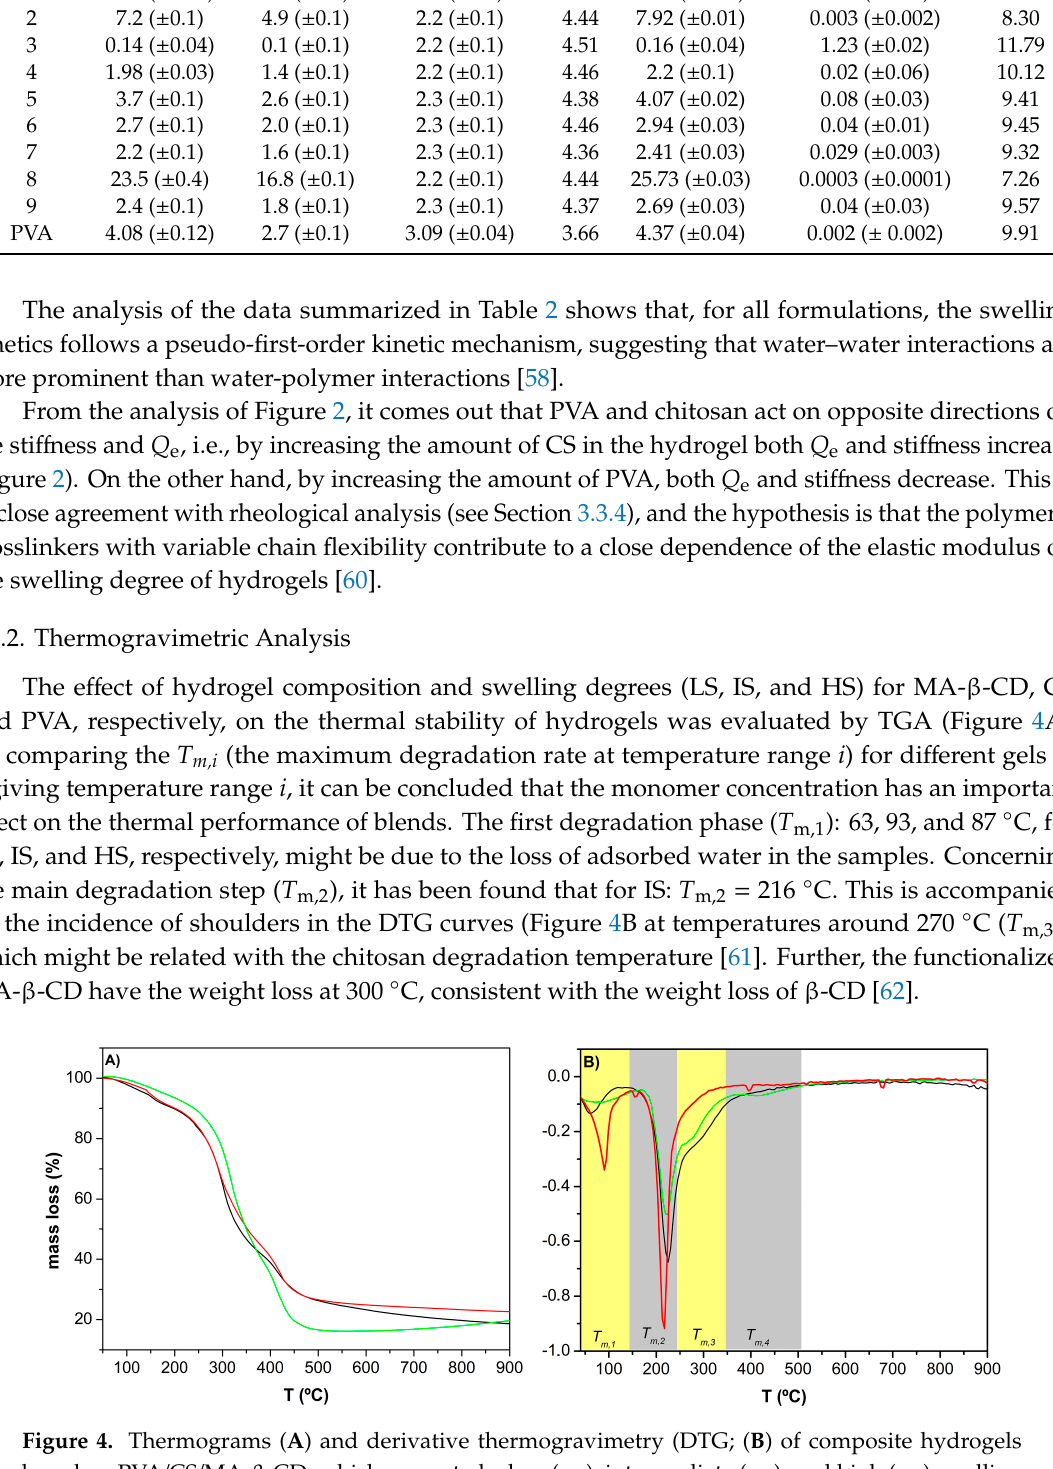
Table 2. Kinetic parameters for the swelling of water by PVA/CS/MA- β -CD-based blends gels, at 25 °C (see Table S2).